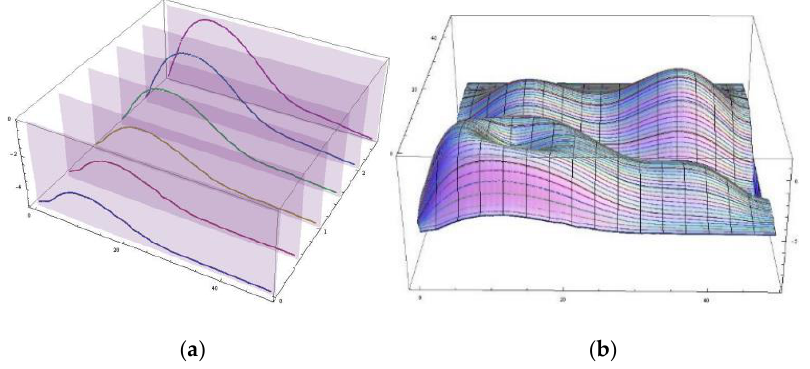
Figure 6. ( a ) First six sectioning plans parallel with xOz and the projected points; ( b ) ordered finishing toolpaths.